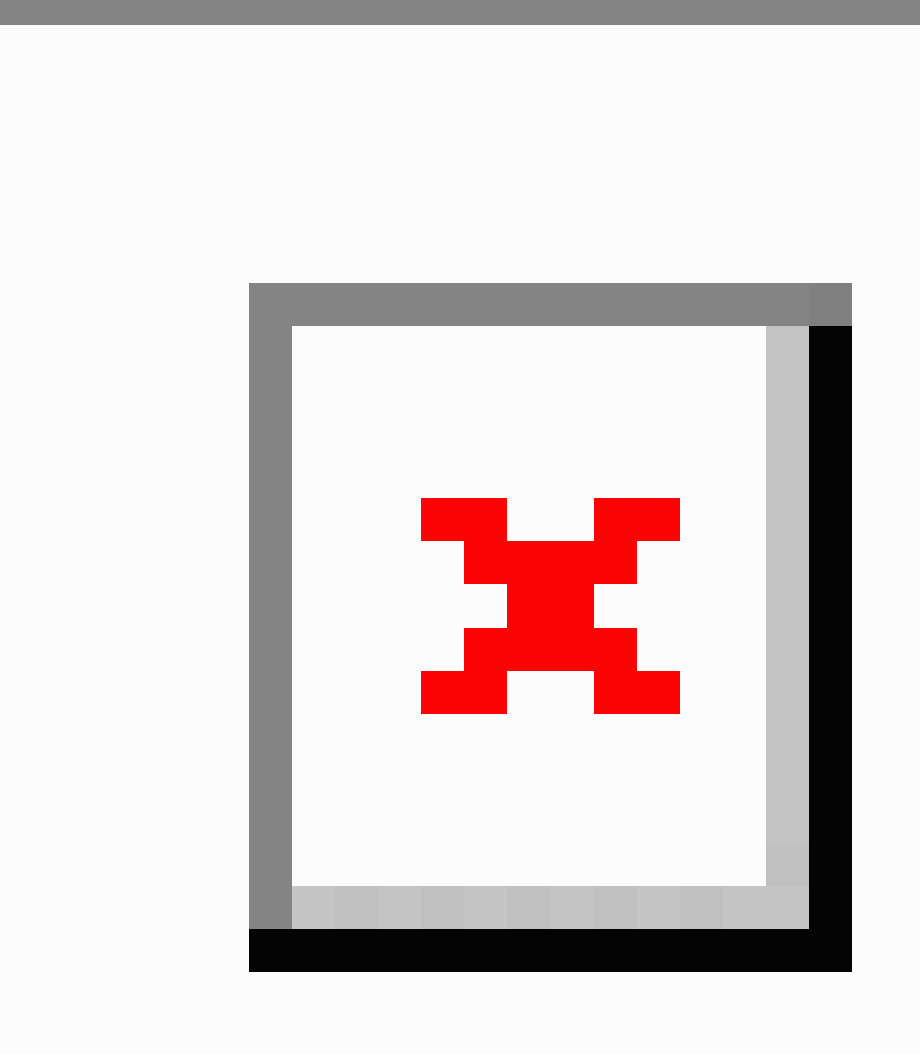
Figure 1. Overview of the study’s methodology. DCE: discrete choice